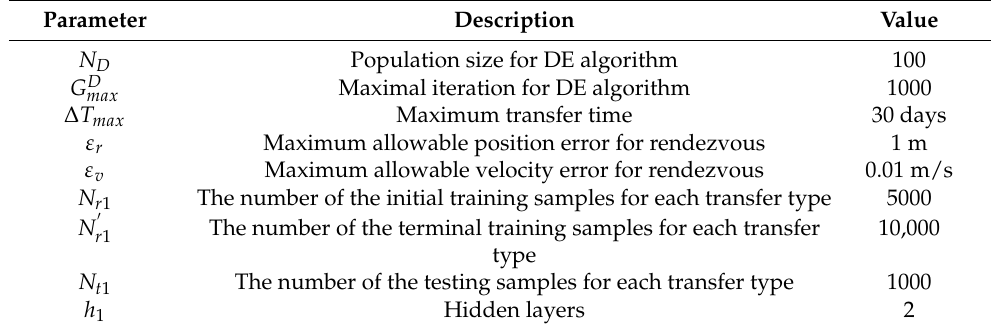
Table 2. Parameters of the experiment for estimation of transfer impulse velocity increment.